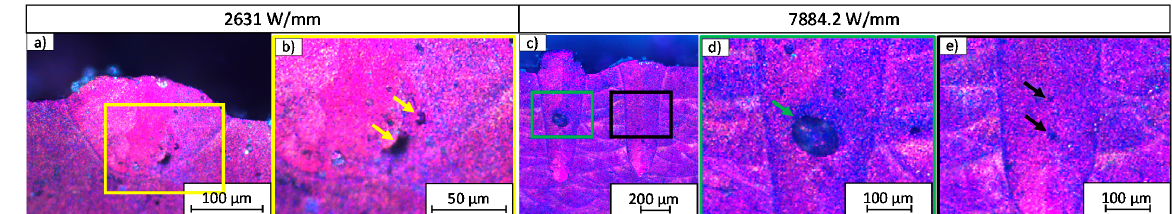
Figure 7. Exemplary images of melt beads with pores. ( a ) Melt bead generated with 𝑃 (cid:3013) /𝑑 (cid:3029) = 2631 W/mm with irregular pores. ( b ) Detail of Figure 7 ( a ) with irregular pores highlighted with yellow arrows. ( c ) Melt beads generated with 𝑃 (cid:3013) /𝑑 (cid:3029) = 7884.2 W/mm with one great spherical pore inside the melt bead (left). Same parameter set on the melt bead on the right side with the formation of small spherical pores only. ( d ) Detail of Figure 7 ( c ) (left) with one great spherical pore highlighted with green arrow. ( e ) Detail of Figure 7 ( c ) (right) with small spherical pores highlighted with black arrows.